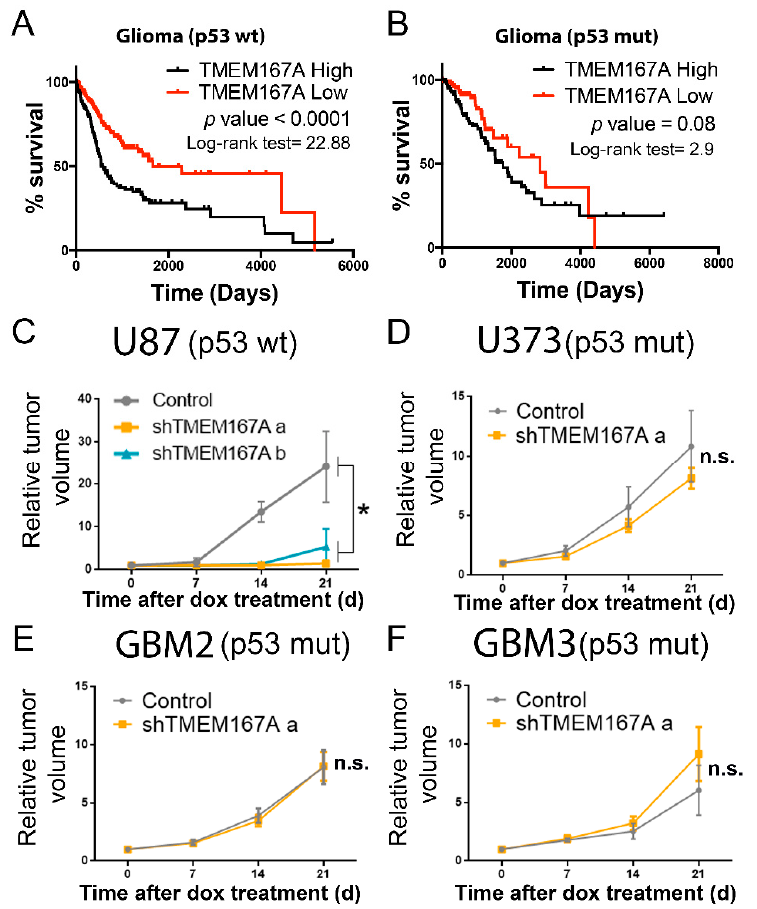
Figure 3. TMEM167A expression correlates with tumor aggressiveness in wild-type but not in mutant p53 gliomas. ( A , B ) Kaplan–Meier overall survival curves of patients from the Rembrandt LGG–GBM cohort. Patients were separated on the basis of the TP53 status: p53 wt ( A ) and p53 mut ( B ). Then they were stratified into two groups on the basis of TMEM167A expression values. ( C – F ) Subcutaneous tumor growth assay of U87 ( C ), U373 ( D ), GBM2 ( E ), and GBM3 ( F ) cells expressing shControl (Control) or shTMEM167A (shTMEM167Aa and shTMEM167Ab) ( n = 6 / group). The graphs were represented as fold increase in tumor volume. * p ≤ 0.05, n.s. = nonsignificant.